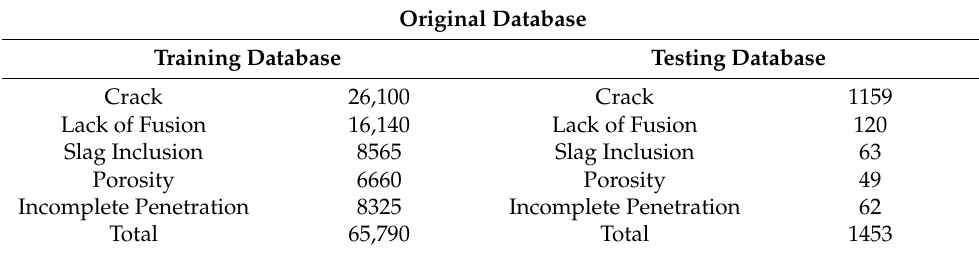
Figure 3. Time shifting of signals: ( a ) 10 points (0.2 µ s) forward and backward shift; ( b ) 20 points (0.4 µ s) forward and backward shift. Table 4. Augmented database (original